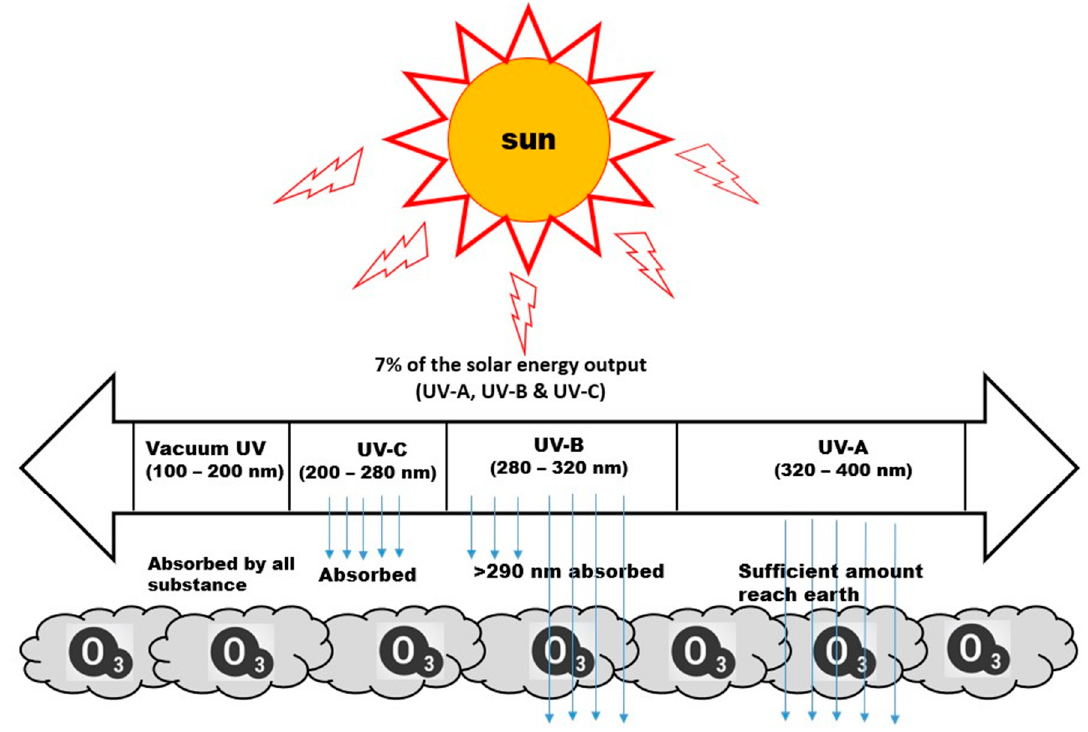
Figure 1. Different regions of UV radiation.